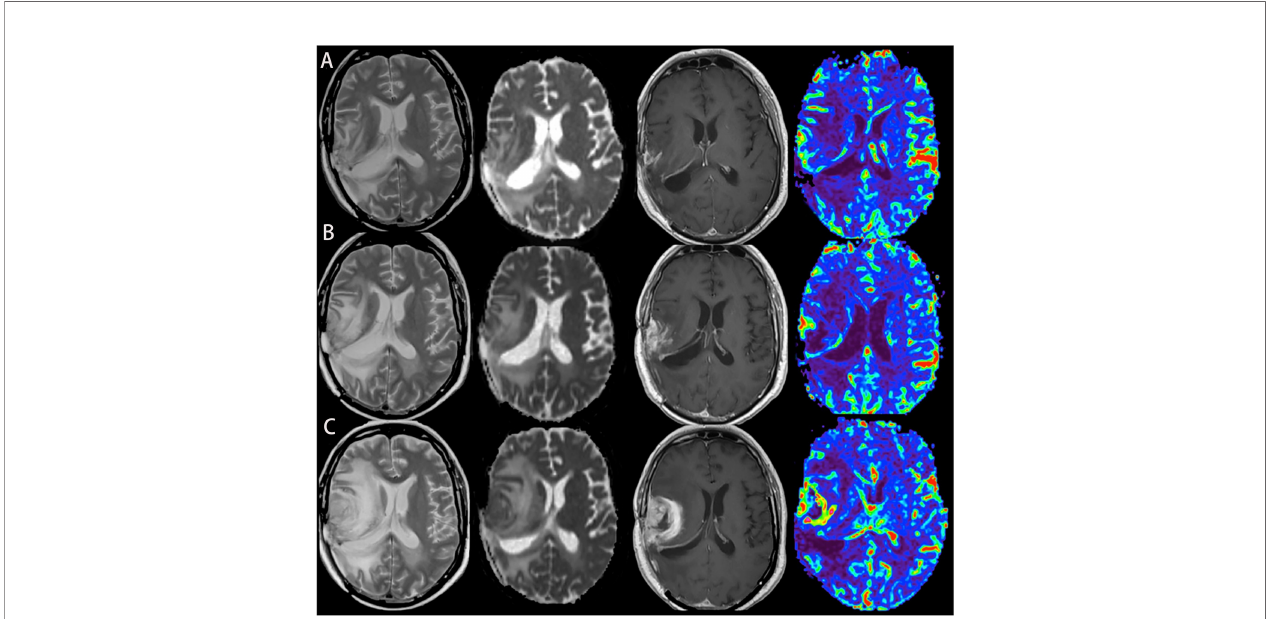
FIGURE 1 | A case of glioblastoma relapsed during immunotherapy, T2, ADC map, T1-enhanced, and CBV map from left to right. (A – C) MRI was performed in the 2nd, 6th, and 8th months of immunotherapy, respectively, showing that the edema degree of the lesion was gradually aggravated, the enhancement was more obvious, and the perfusion was higher.